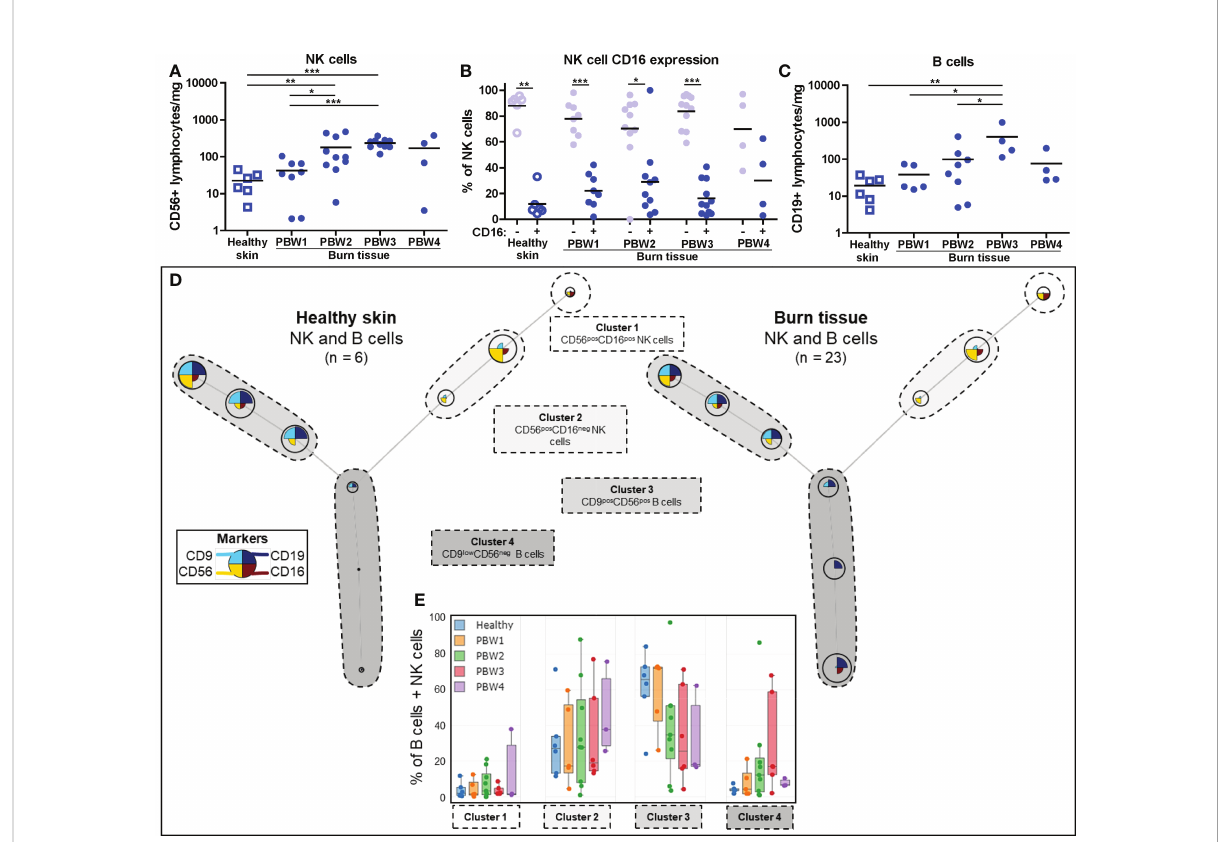
FIGURE 5 Local NK and B cell response to burn injury. Flow cytometry-based quanti fi cation of: (A) Absolute number of NK cells (CD56 + lymphocytes) per mg tissue; (B) Percentage of NK cells that are CD16 - and CD16 +; (C) Absolute number of B cells (CD19 + lymphocytes) per mg tissue. (D) Unsupervised clustering of NK and B cells in healthy skin and burn tissue, 4 clusters are highlighted. Node size represents relative size of population and node diagram shows expression level of markers. (E) Percentage of NK or B cells within each cluster. Error bars in E show boxplot, p values were calculated using Mann-Whitney U statistical tests, signi fi cant differences are indicated by black asterisks: *p < 0.05; **p < 0.01; ***p <